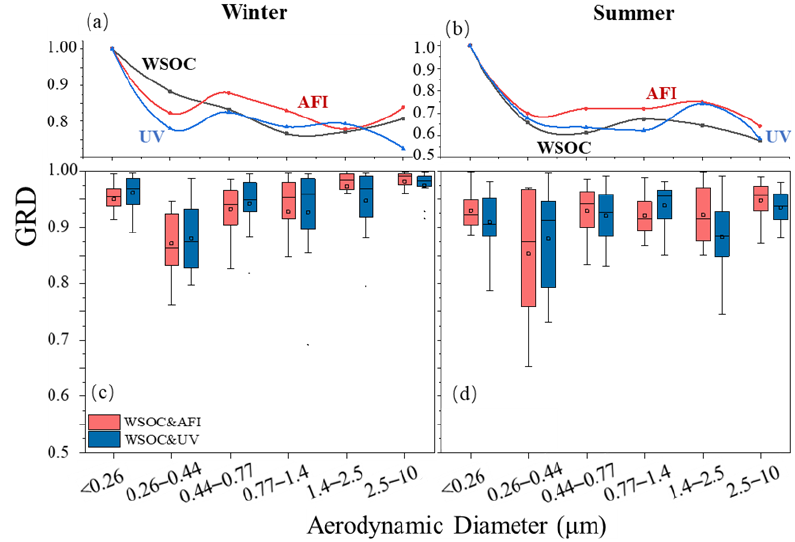
Figure 7. The GRD of size-segregated WSOCs, AFI, and average UV: (a,b) the GRD calculated by the WSOCs, AFI, and average UV of each sample, setting data < 0.26µm as a reference, GRD ( < 0.26) = 1; (c,d) the GRD between the WSOCs and the light absorption indices, setting WSOCs as a